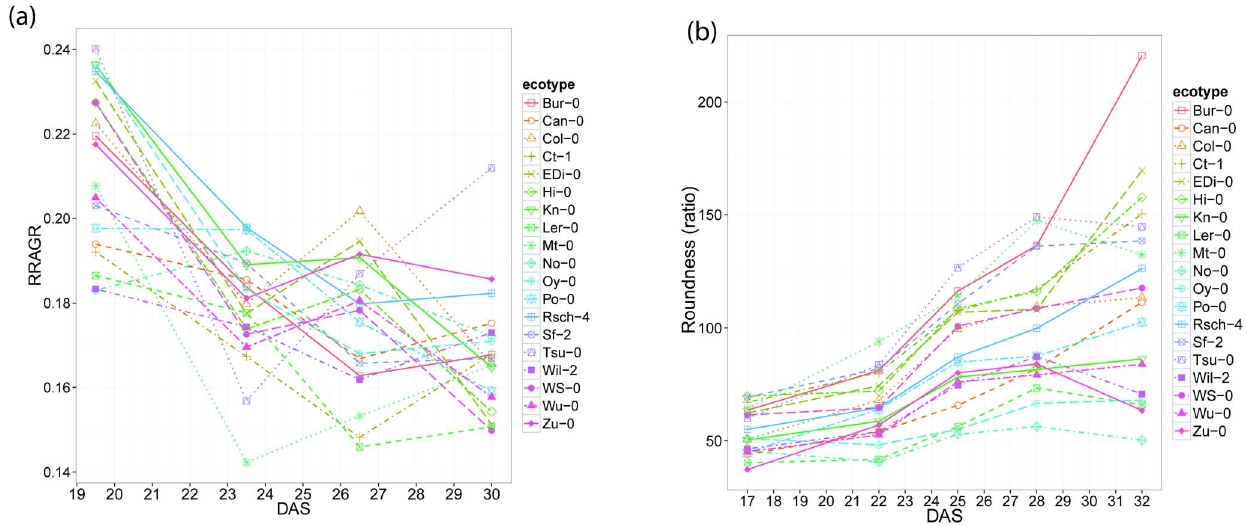
Figure 7. Shape descriptors over time. (A) Relative Rosette Area Growth Rate Over Time (RRAGR), (B) Compactness.